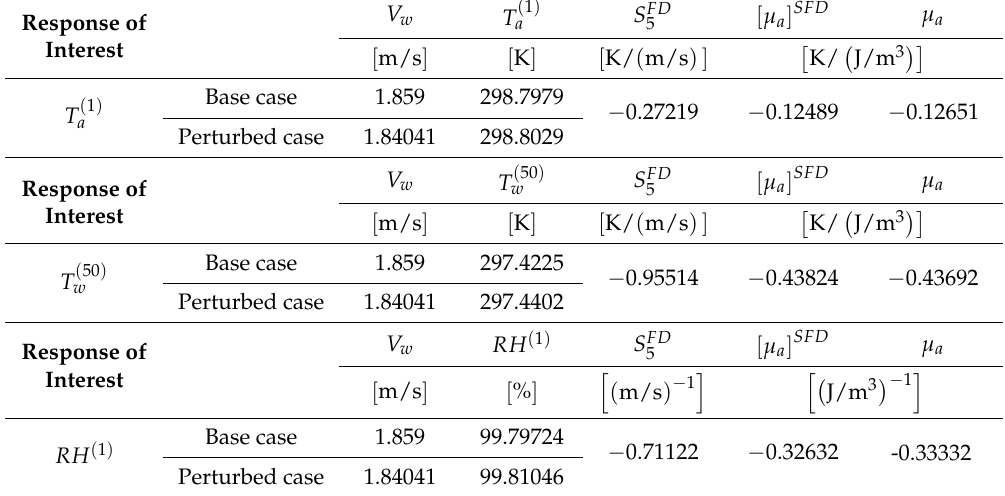
Table E1. Verification Table for adjoint function µ a with respect to the responses T ( 50 ) m